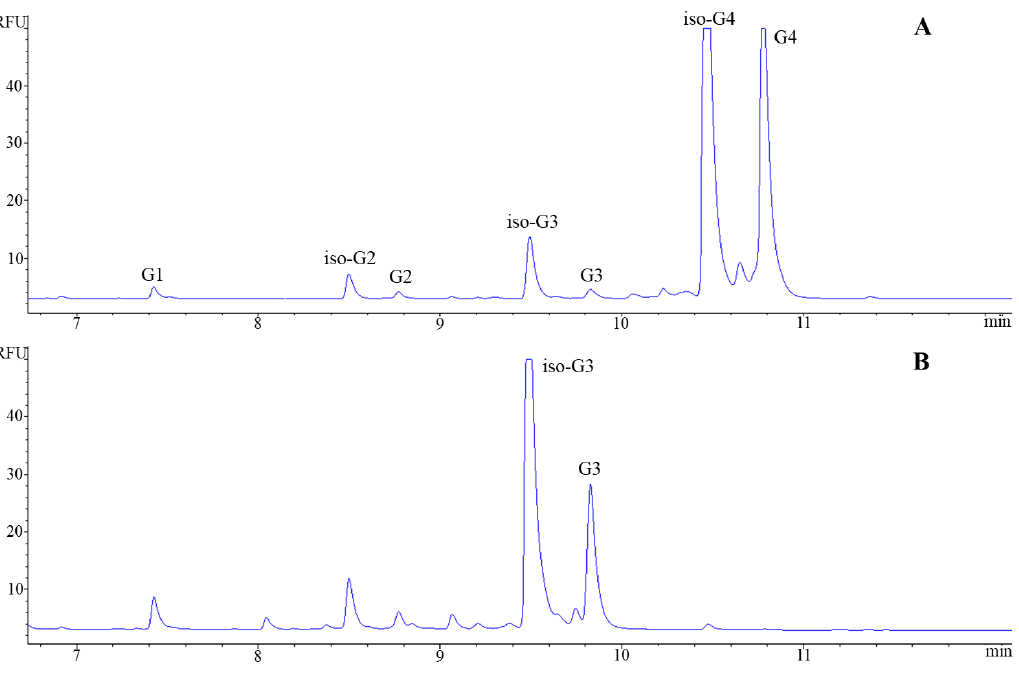
Figure 3. The analysis of isomaltotetraose ( A ) and isomaltotriose ( B ) by CZE-LEDIF. The analysis conditions were the same as stated at Figure 2B. Table 1. Analytical performance data of fructose and glucose. The analysis conditions were the same as stated at Figure